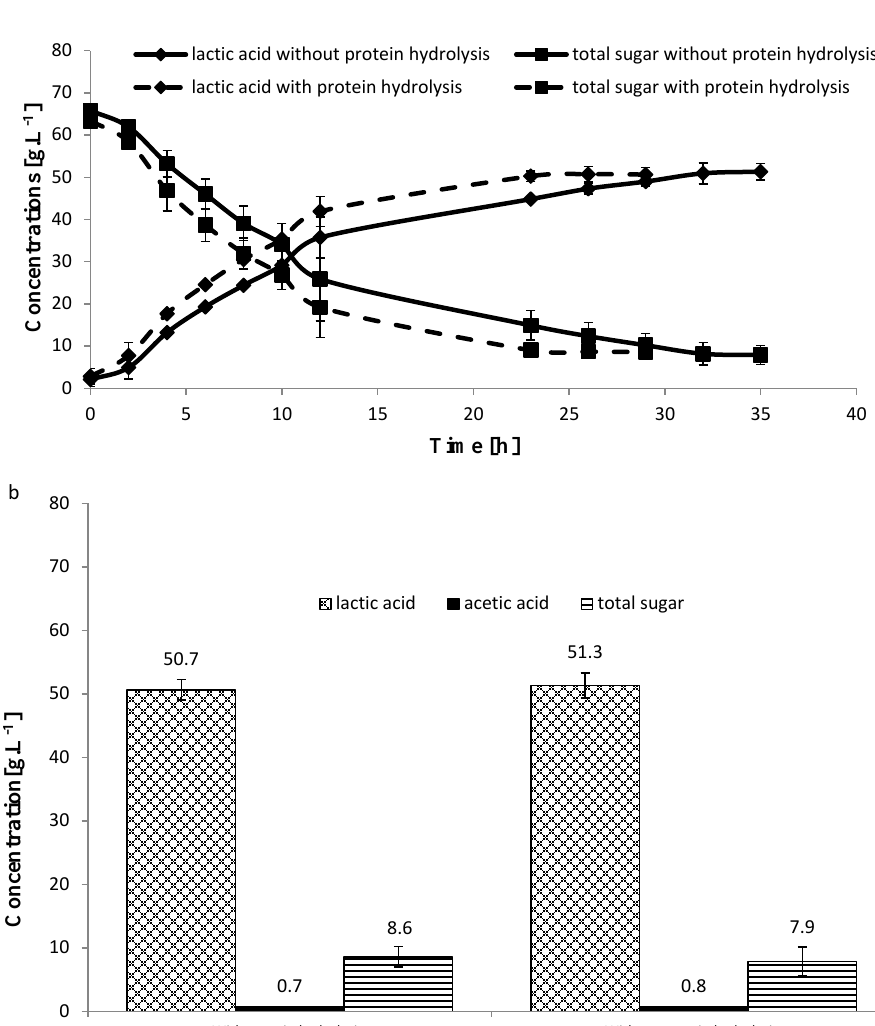
Figure 4. Lactic acid production and remaining sugars trend during fermentation after enzymatic sugar hydrolysis of carob biomass (30% DM) followed with or without protein hydrolysis conducted in one liter fermenter without yeast extract using isolate A107 ( a ) and comparison end of total lactic acid, acetic acid, and total sugars after fermentation ( b ). Each data point represents average of two replicates.